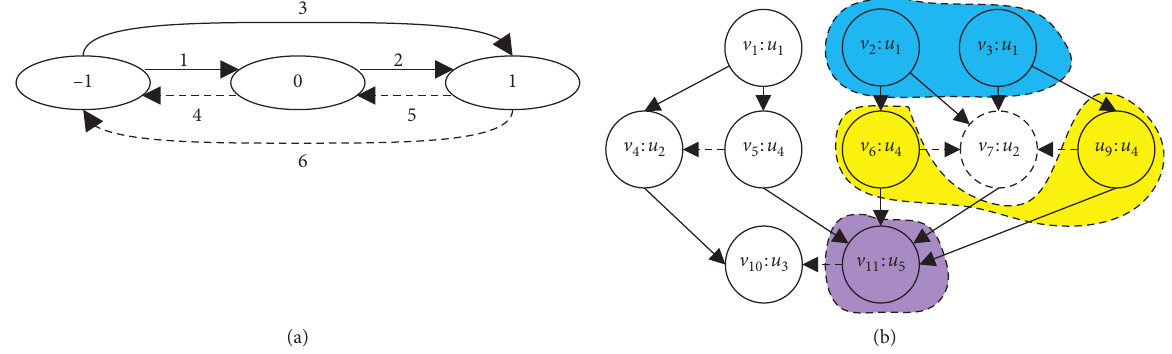
Figure 6: (a) State transition model and (b) adjacent influence of v7 of candidate